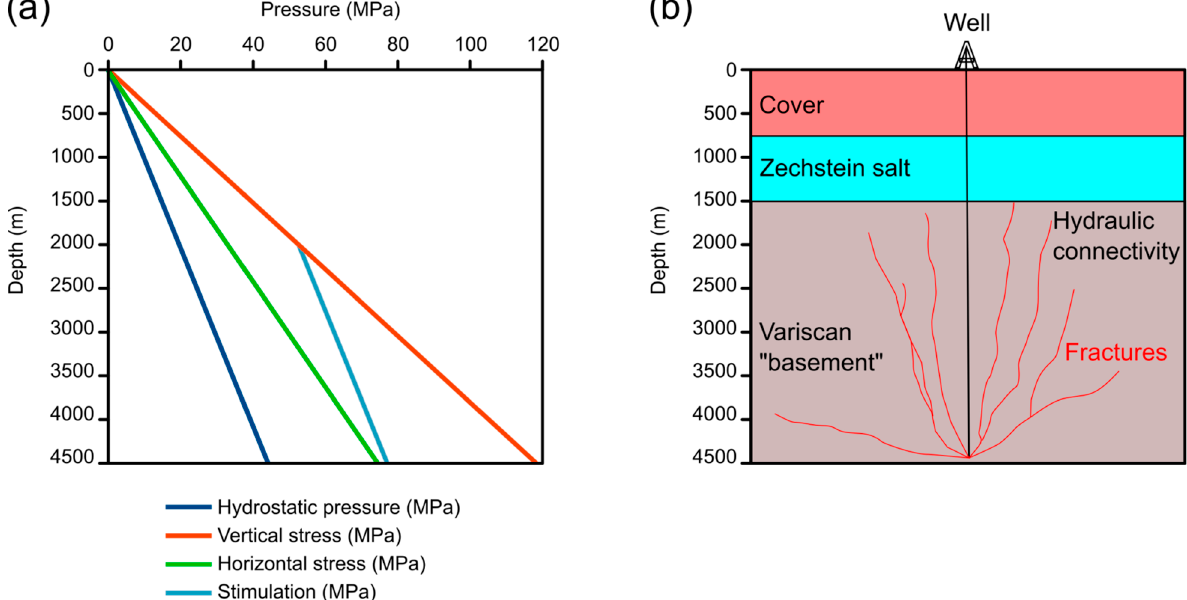
Figure 7. (previous page). Schematic figure for likely effects of stimulation on the folded and cleaved Devonian and Carboniferous greywackes and slates, based on the results presented in Table 4. The fold has an amplitude of a few metres to tens of metres. The model is for a depth of 2 km, at which hydrostatic fluid pressure would be 19.62 MPa. Veins are shown in the greywackes in the outer arcs of folds, and a fanning axial planar cleavage is shown (e.g., Stephan et al., 2016). Joints are drawn approximately perpendicular to bedding. We predict the following sequence of events as fluid pressure is increased. ( a ) Favourably ‐ orientated cohesionless fractures (joints) may be critically ‐ stressed in greywackes with very low geostatic stress ratios, so may undergo normal faulting even at hydrostatic fluid pressure. ( b ) Shear can occur along favourably ‐ orientated joints in the slates at fluid pressures of about 50 MPa. ( c ) Gently ‐ dipping extension fractures can be generated in the slates at fluid pressures at about 68 MPa, and gently ‐ dipping joints in the greywackes may be reactivated as extension fractures. ( d ) Extension fractures with any orientation may develop in the slates at fluid pressure between about 90 and 105 MPa. ( e ) Gently ‐ dipping extension fractures can be generated in the greywackes at fluid pressures of about 72 MPa. ( f ) Extension fractures with any orientation may develop in the greywackes if the fluid pressure is between about 100 and 210 MPa.